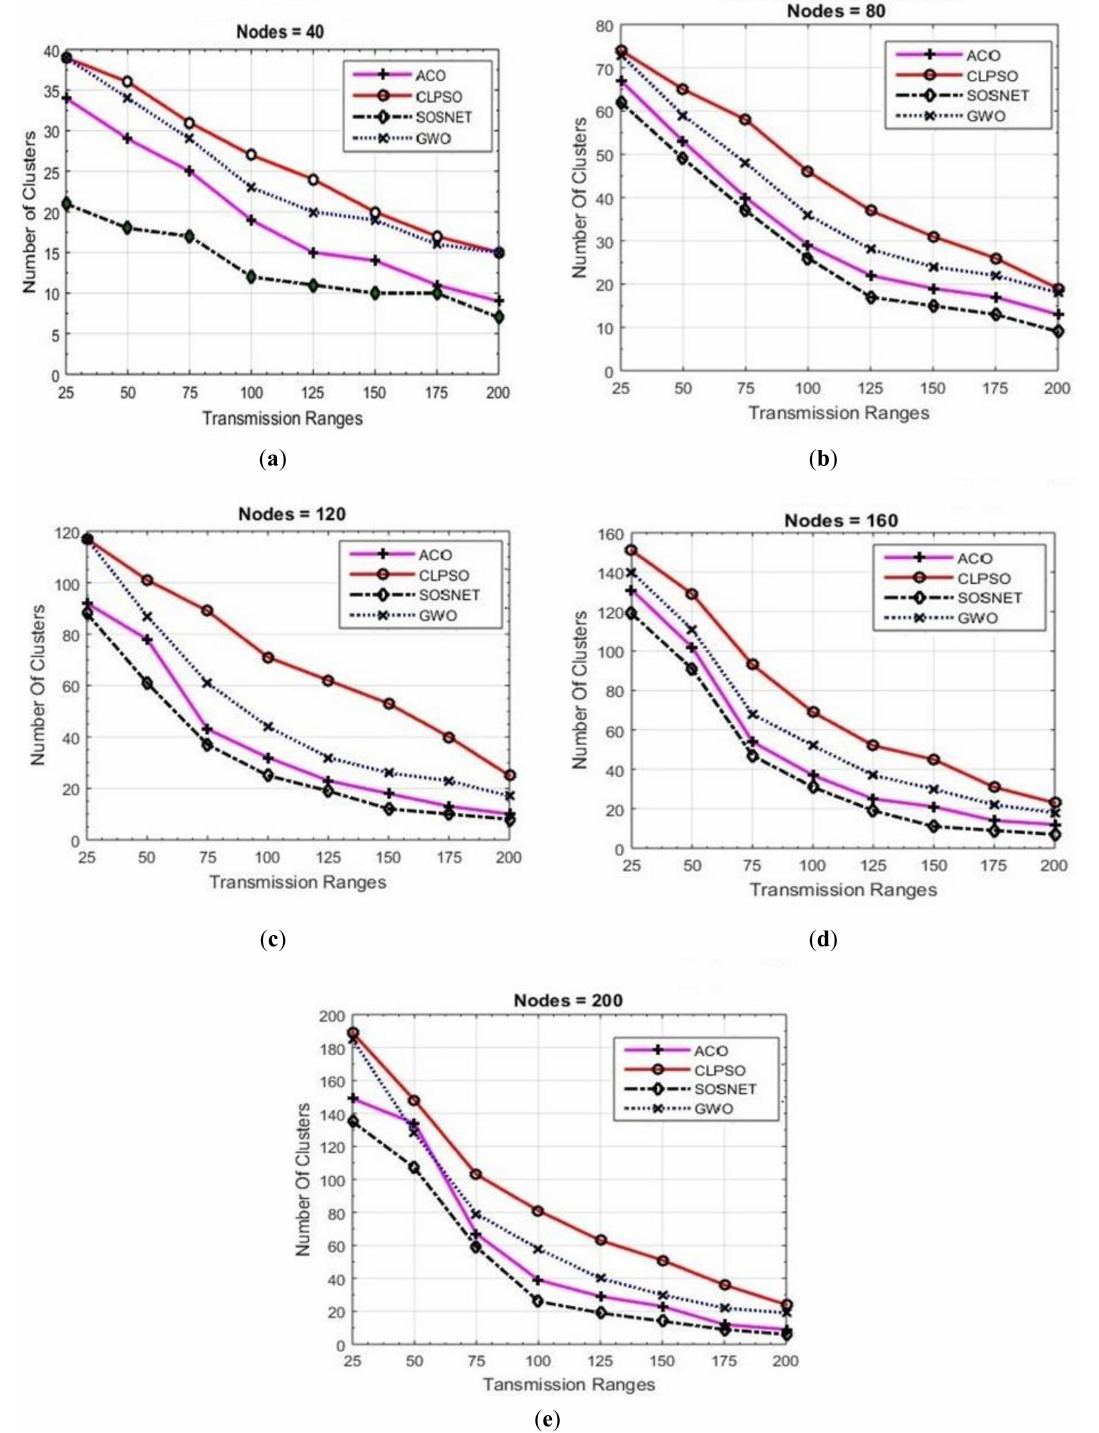
Figure 5. Grid size 1000 m × 1000 m, nodes 40 to